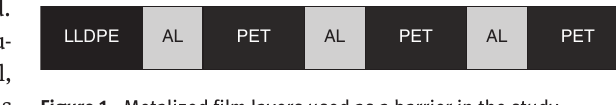
Figure 1 Metalized film layers used as a barrier in the study.